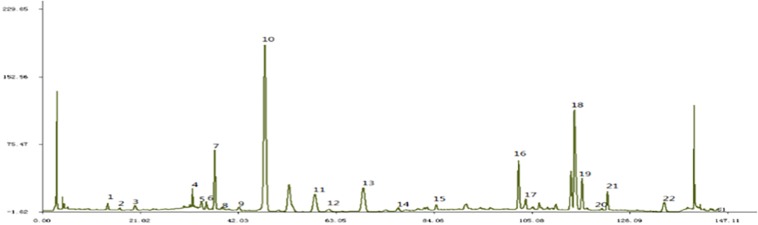
Fingerprint of JTXK granule. Paeonol (22), Salvia acid B (18), Berberine (19), Coptisine (16), Puerarin (10).